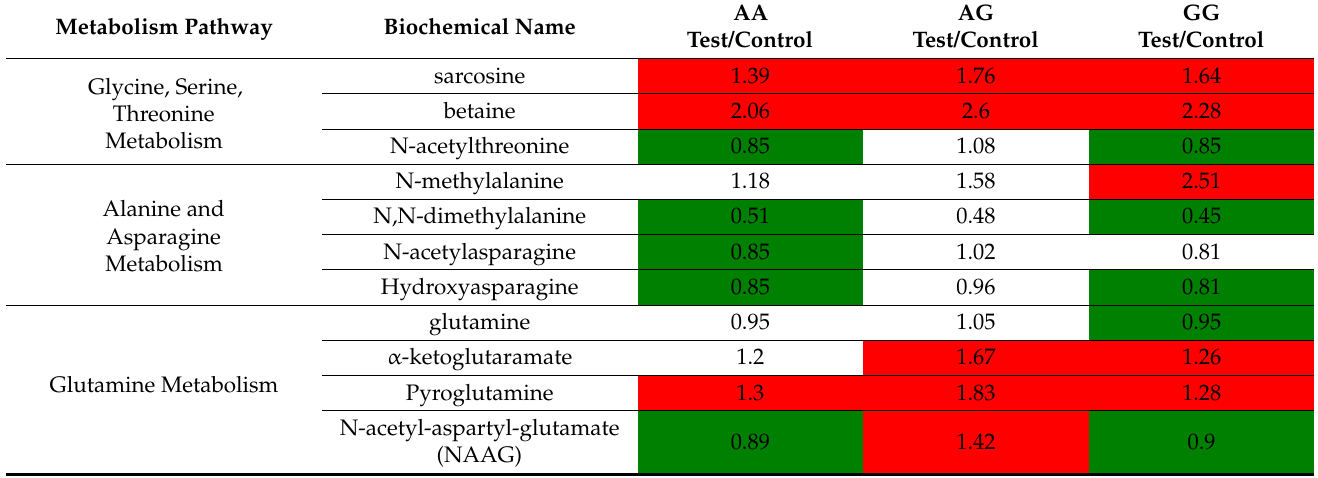
Table 7. Ratios of the concentrations of selected serum metabolites in cats with different alanine- glyoxylate aminotransferase 2 (AGXT2) single nucleotide polymorphisms (SNPs) that were signifi- cantly different (all analytes that had a p ≤ 0.05 and a q ≤ 0.1 for an effect of food) after consuming control or test food for 28 days. Green denotes a decline and red an increase in the ratio (test food concentration/control food concentration) of each